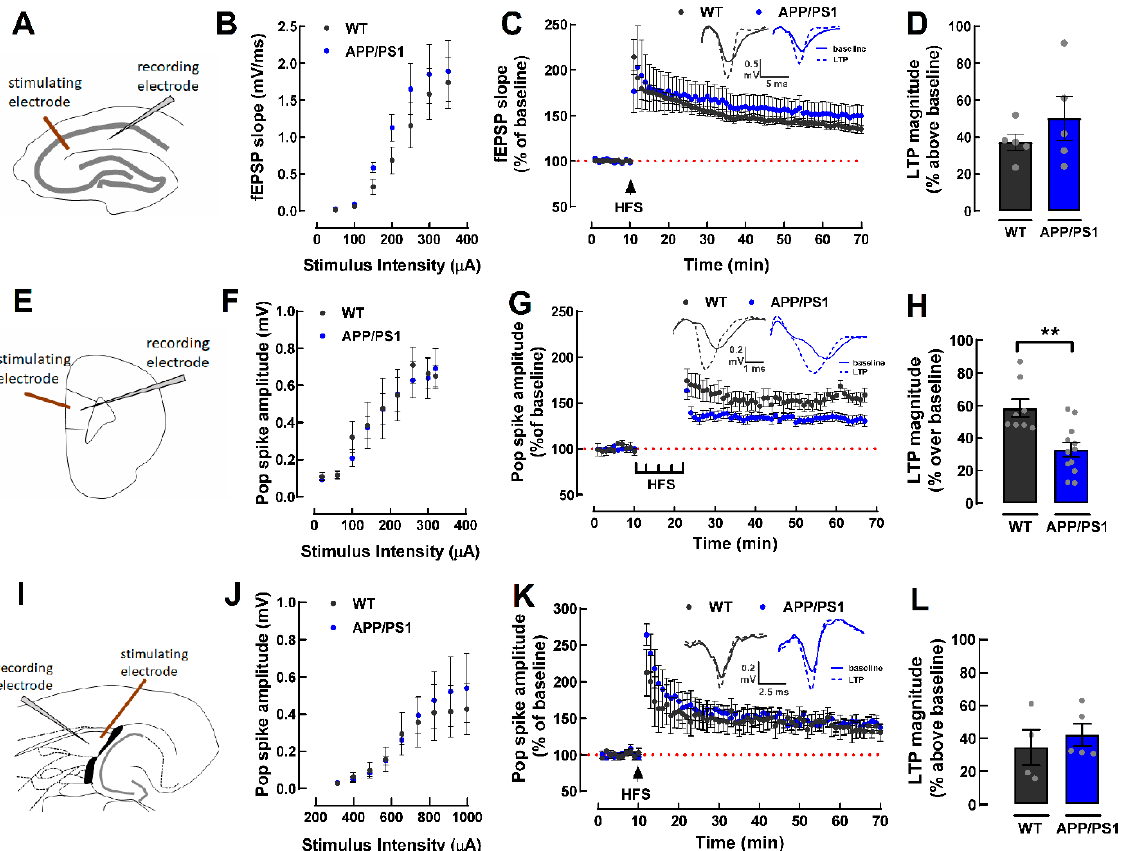
Figure 3. Synaptic transmission and plasticity in the dorsal hippocampus, prefrontal cortex, and amygdala of 9-month-old female WT and APP/PS1 mice. In the dorsal hippocampus, synaptic trans- mission was measured in Schaffer fibers-CA1 pyramid synapses ( A ) by measuring the slope of field excitatory postsynaptic potentials (fEPSP). WT and APP/PS1 mice displayed similar input/output response ( B ) and similar magnitude of long-term potentiation (LTP), triggered by a high-frequency train (HFS, 100 Hz for 1 s) ( C , D ). In the prelimbic prefrontal cortex (PFC), synaptic transmission between pyramidal neurons in layer II/III and layer V ( E ) was measured as the amplitude of the population spike (PS) responses. WT and APP/PS1 mice displayed similar input/output response ( F ), but relative to the WT, APP/PS1 mice displayed a decreased LTP magnitude, triggered by a high- frequency train (HFS, 5 trains of 300 pulses at 100 Hz every 3 min) ( G , H ). Inside the lateral amygdala ( I ), synaptic transmission was measured as the amplitude of the PS responses. WT and APP/PS1 mice displayed similar input/output response ( J ) and similar LTP magnitude, triggered by a high- frequency train (HFS, 3 trains of pulses of 100 Hz delivered every 5 s) ( K , L ). Data are mean ± SEM of 4–12 experiments (number of di ff erent animals tested). ** p < 0.01, Student’s unpaired t -test.